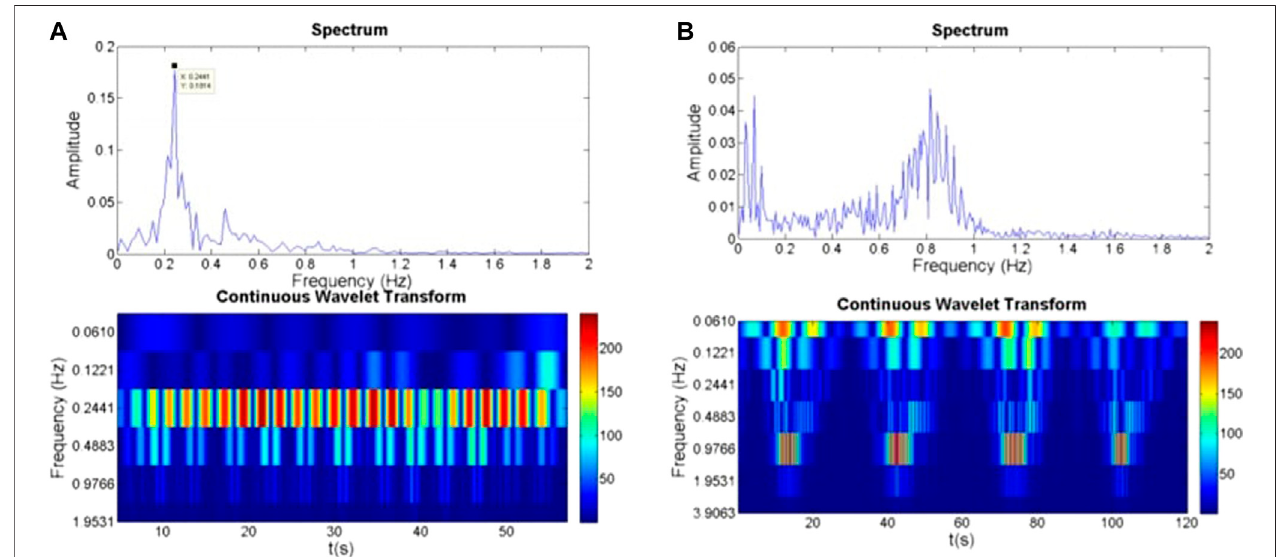
FIGURE 4 | Spectral density (FFT) and continuous wavelet transform of normal breathing, (A) , and Cheyne Stokes breathing, (B) . Taken from Lee et al. (2014).